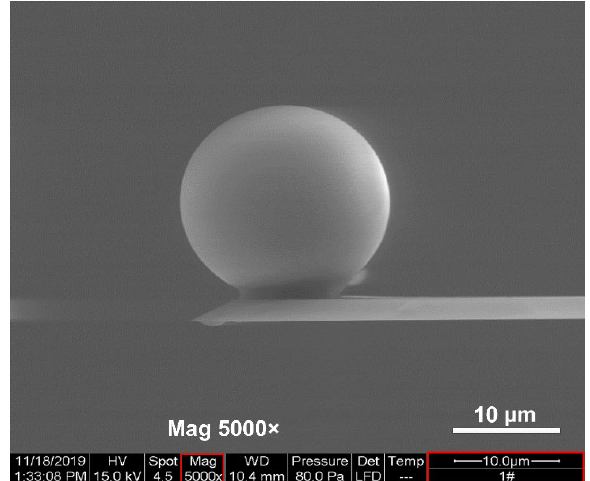
Fig. 4 SEM image of PS beads: 5000× magnification.